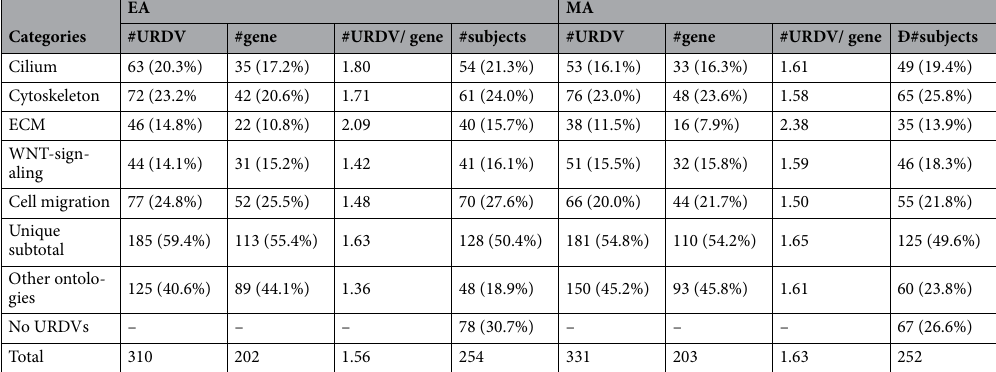
Table 1. Distribution of URDVs and genes in five biological ontology groups among MMC subjects. Note. Count of URDV, or neural tube defect candidate gene, or subjects with myelomeningocele are shown with the percentage to the total count of each column in bracket. Some genes are classified to more than one category. Count of URDVs, or gene or individual are presented follow by the percentage of the count presented in bracket. Some genes can be assigned to more than one ontology categories. A unique subtotal count shows the subtotal number of the URDV, or gene, or subject without double counting when a gene has multiple ontology groups assigned. Not in above – represent URDVs, genes or subjects outside the five ontologies. URDV— ultra-rare deleterious variant, EA—European American subject, MA—Mexican American subject. ECM – extracellular